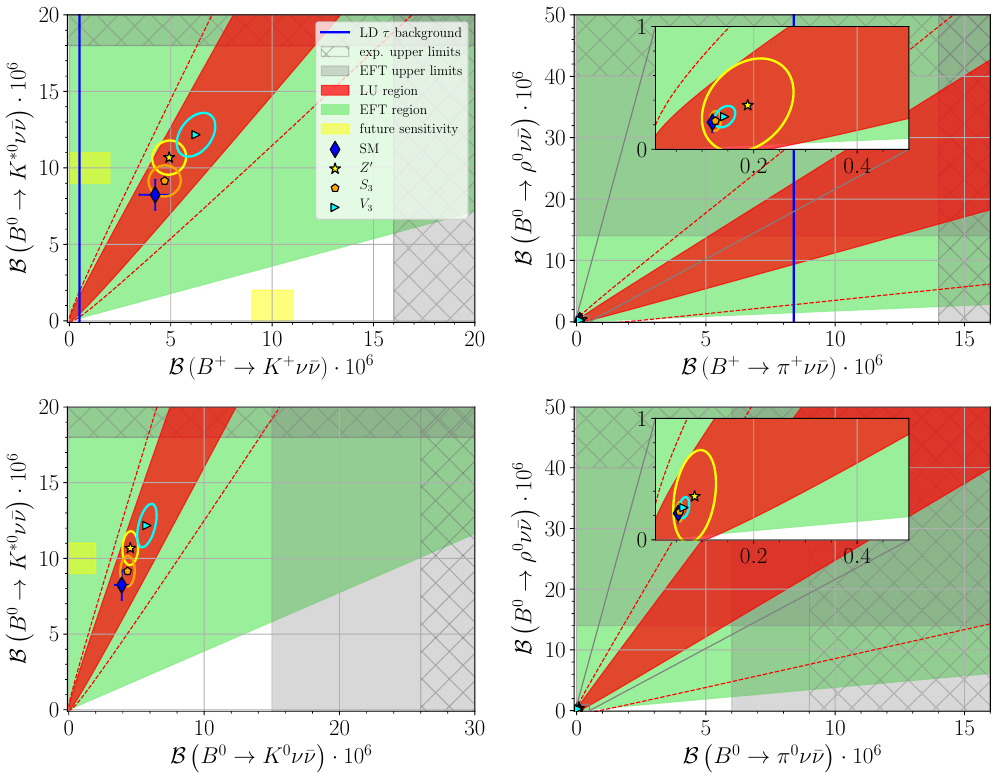
Figure 2 . The figure is split into a left panel for b → s and a right panel for b → d transitions. Upper left: B ( B 0 → K ∗ 0 ν ¯ ν ) versus B ( B + → K + ν ¯ ν ) . SM predictions (blue diamond) with their uncertainties (blue bars) from table 2, where we have included the resonant τ -background in the charged mode as an additional uncertainty (cf. section 3).The region to the left of the solid blue line is governed by pure resonant contributions (3.7), (3.8). Dark red region (dashed red lines) represent the LU region given by eq. (5.6) where κ bsµµ and A have been scanned within their 1 σ ± R ( 2 σ ) uncertainties. The light green region represents the validity of our EFT framework, eqs. (4.1) and (4.2). Assuming eq. (5.8), we provide specific LU BSM benchmarks, which result in best fit values (markers) and 1 σ regions (ellipses) for Z 0 (red star), LQ representations S (pink pentagon) 3 and V (celeste triangle) from b → s µ + µ − global fits. Hatched gray bands correspond to current 3 experimental 90% CL upper limits in table 2. The widths of the yellow boxes illustrate the projected experimental sensitivity of Belle II with 50 ab − 1 in table 2. Lower left: similar to upper left plot, but for B ( B 0 → K ∗ 0 ν ¯ ν ) versus B ( B 0 → K 0 ν ¯ ν ) . Upper right: B ( B 0 → ρ 0 ν ¯ ν ) versus B ( B + → π + ν ¯ ν ) with labeling similar to upper left plot. The plot includes a zoom into the region around the SM expectation. The τ -background (solid blue line) is not included as an uncertainty in B + → π + ν ¯ ν as it dominates the SM prediction by two orders of magnitude. Lower right: similar to upper right plot but for B ( B 0 → ρ 0 ν ¯ ν ) versus B ( B 0 → π 0 ν ¯ ν )